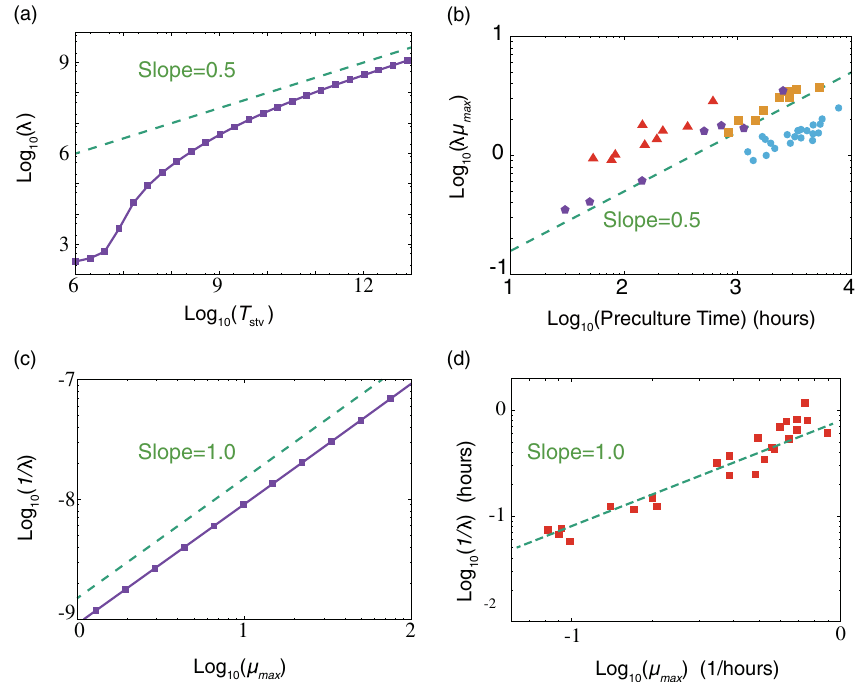
FIG. 2. (a,b) Lag time as a function of (a) starvation time or (b) preincubation time. The lag time is scaled by the maximum growth rate (inversely proportional to the shortest doubling time in the substrate-rich condition). Purple pentagons, cyan dots, and orange squares are adopted from Figs. 3, 6(a), and 6(b) of Augustin et al. [12], respectively, and the red triangles are extracted from the data in Table 1 of Pin et al. [40]. (c,d) Relationship between the lag time and maximum specific growth rate μ . Data are adopted from Table 1 of Oscar [39]. max 10 4 , S poor 10 − 2 , v ¼ 0 . 1 , k 1 . 0 , k 10 − 6 , K ¼ 1 . 0 , K 10 . 0 , and d d d 0 Parameters were set as follows: S rich p ¼ m ¼ t ¼ A ¼ B ¼ C ¼ ext ¼ ext ¼ (the same parameter values as in Fig. 1 except d i s). The lag time is computed as the time needed to reach the steady state under the S S rich condition from an initial condition in the inactive phase. In panel (c), it is obtained by varying v ð¼ μ ext ¼ max Þ ext